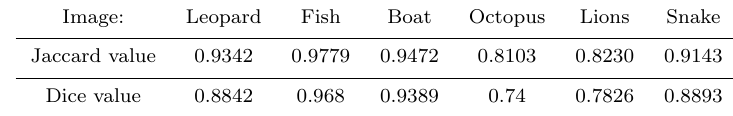
Table 2. Comparison results based on similarity coefficients.